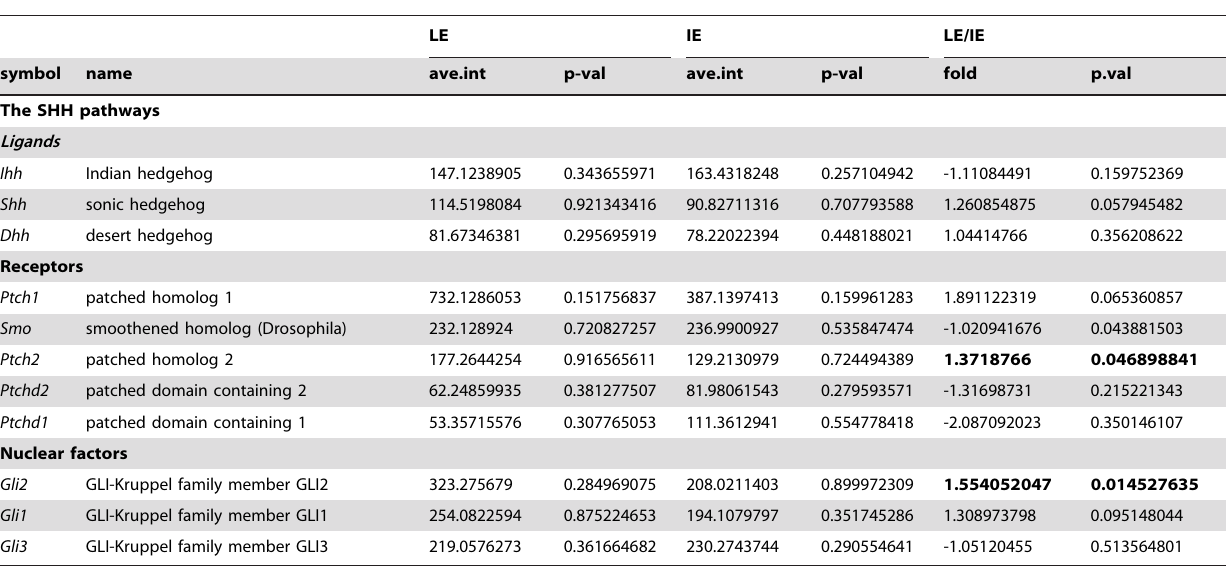
Table 8. Expression of genes in the Shh pathways